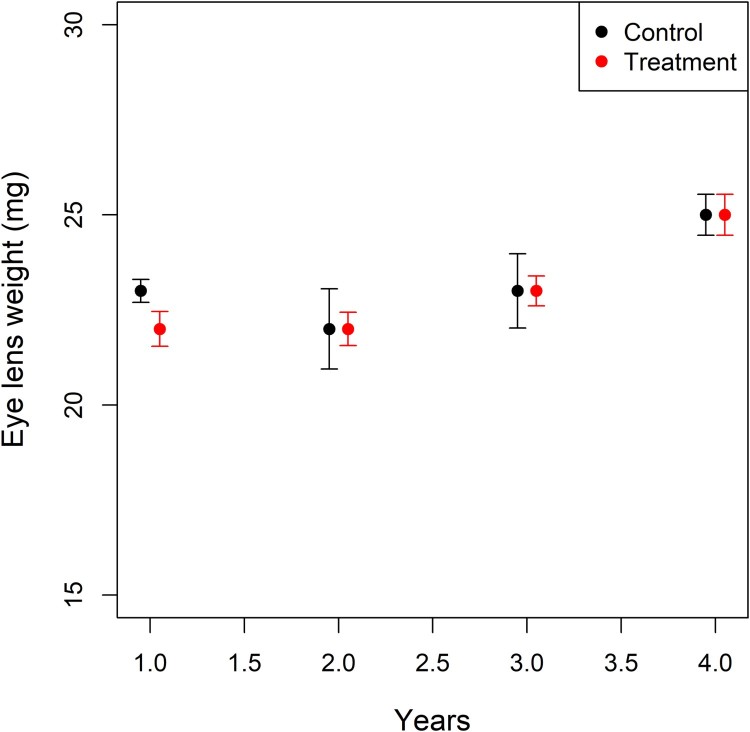
Mean eye lens weight (ELW) of M. natalensis for the control (black) and treatment villages (red) in function of year. The ELW is used as a proxy for age in the rodents. The error bars indicate standard errors on the means.